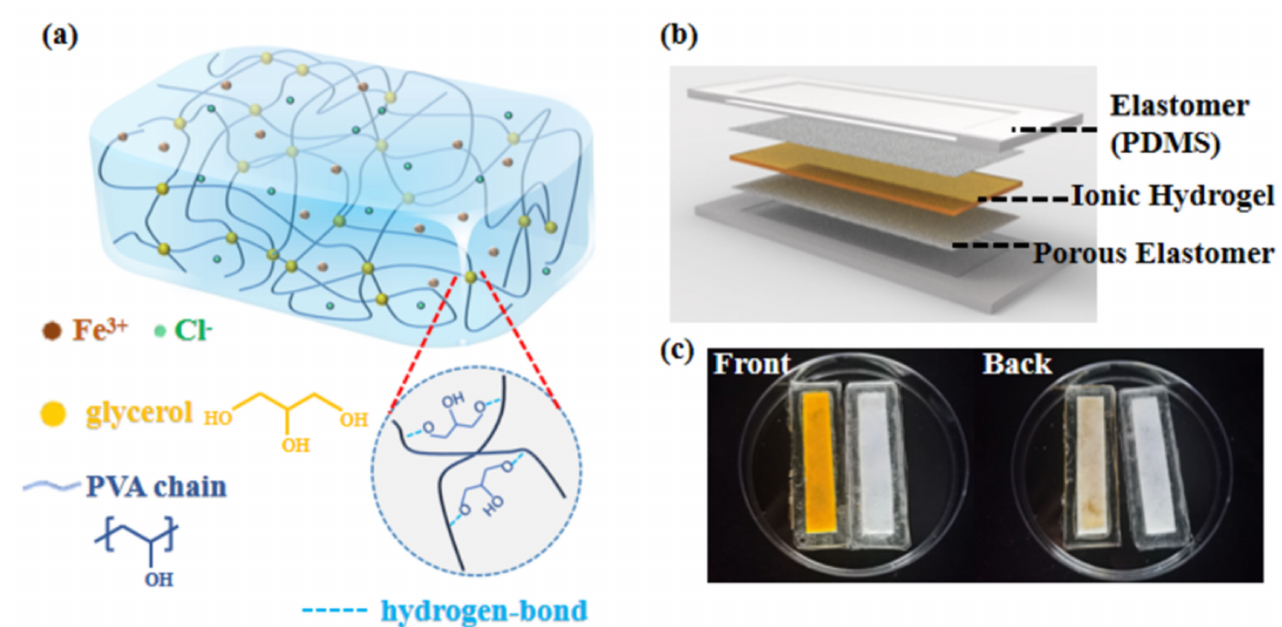
Figure 1. Scheme structure of ( a ) PVA-G-FeCl 3 hydrogel and ( b ) PDMS-encapsulated ionic hydrogel. ( c ) Photos of PDMS-encapsulated PVA-G-FeCl 3 and PVA-G hydrogel (for easy viewing, only the back side has a porous